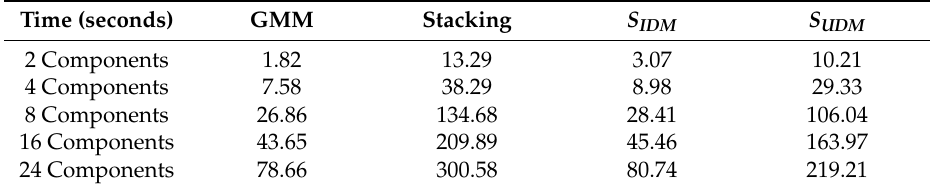
Table 2. Average training time with respect to the number of Gaussian components.